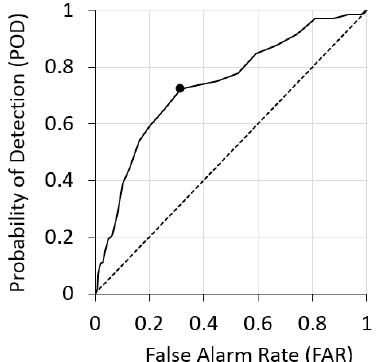
Figure 5. Example receiver operating characteristic (ROC) curve, with threshold value indicated.